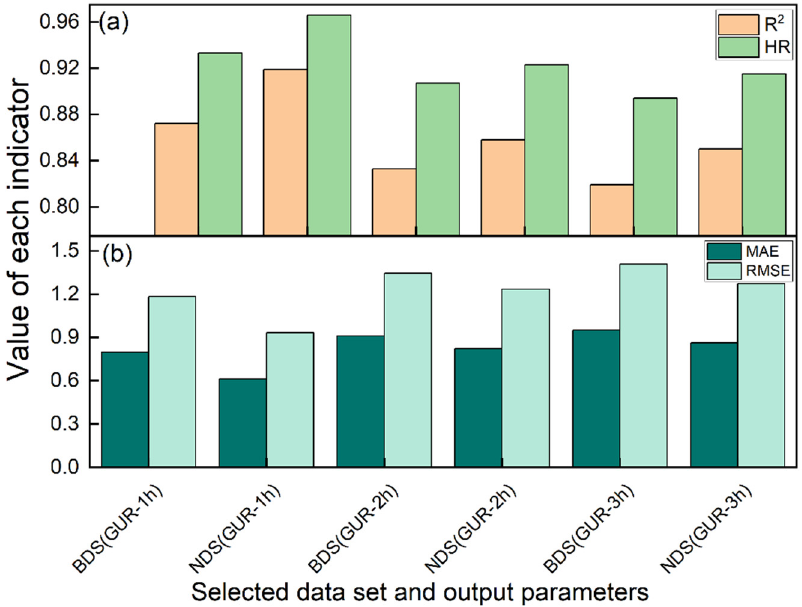
Figure 12. R 2 and HR values of the two models ( a ), and MAE and RMSE of the two models ( b ).